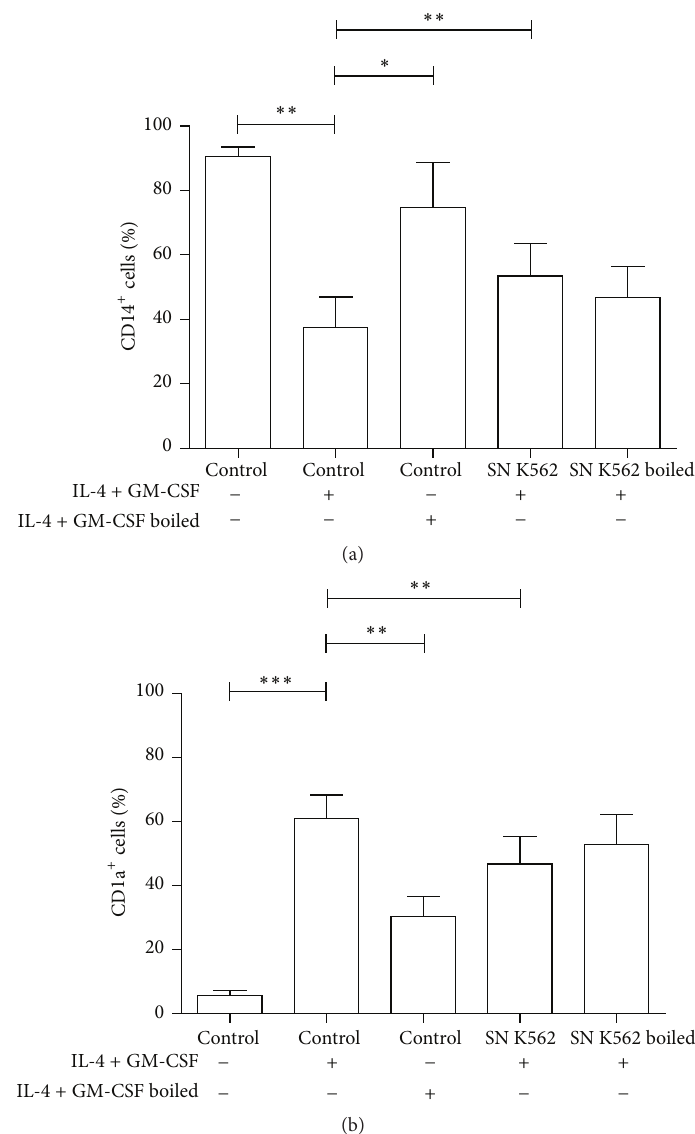
Figure 3: Leukemic cell-derived proteins effect on monocytes differentiating into dendritic cells. Mononuclear cells were obtained after gradient density from buffy coats of healthy individuals. After 2 h of adhesion, lymphocytes were removed and monocyte cultures were stimulated with IL-4 and GM-CSF (50 ng/mL) to induce dendritic cell differentiation. K562 supernatants (SN K562) were obtained after 3 days of cell culture in RPMI plus 10% of fetal bovine serum (FBS) followed by filtering (0.22 𝜇 m). Part of tumor supernatant and part of IL-4 and GM-CSF were boiled for 10 minutes at 100 ∘ C in order to denature proteins. After cooling, some cells were incubated with these supernatants or cytokines at the same concentration described above for 5 days. Anti-CD14 FITC and anti-CD1a PE were used to stain the cells and data were assessed by a FACS Calibur. Graphs show mean ± SEM of the percentage of CD14 + (a) and CD1a + (b) cells. ∗ 𝑝 ≤ 0.05 ; ∗∗ 𝑝 ≤ 0.01 ; ∗∗∗ 𝑝 ≤ 0.001 . 𝑛 ≥ 5